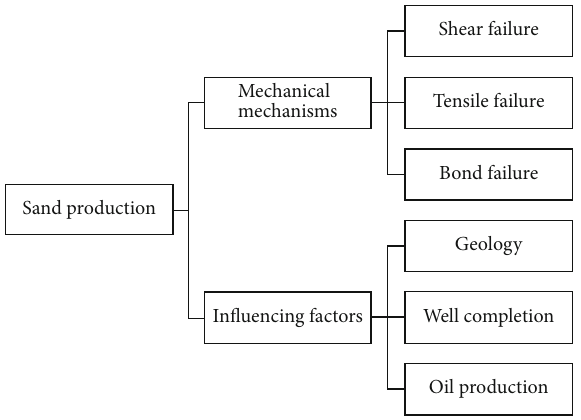
Figure 1: General sketch of the sand production